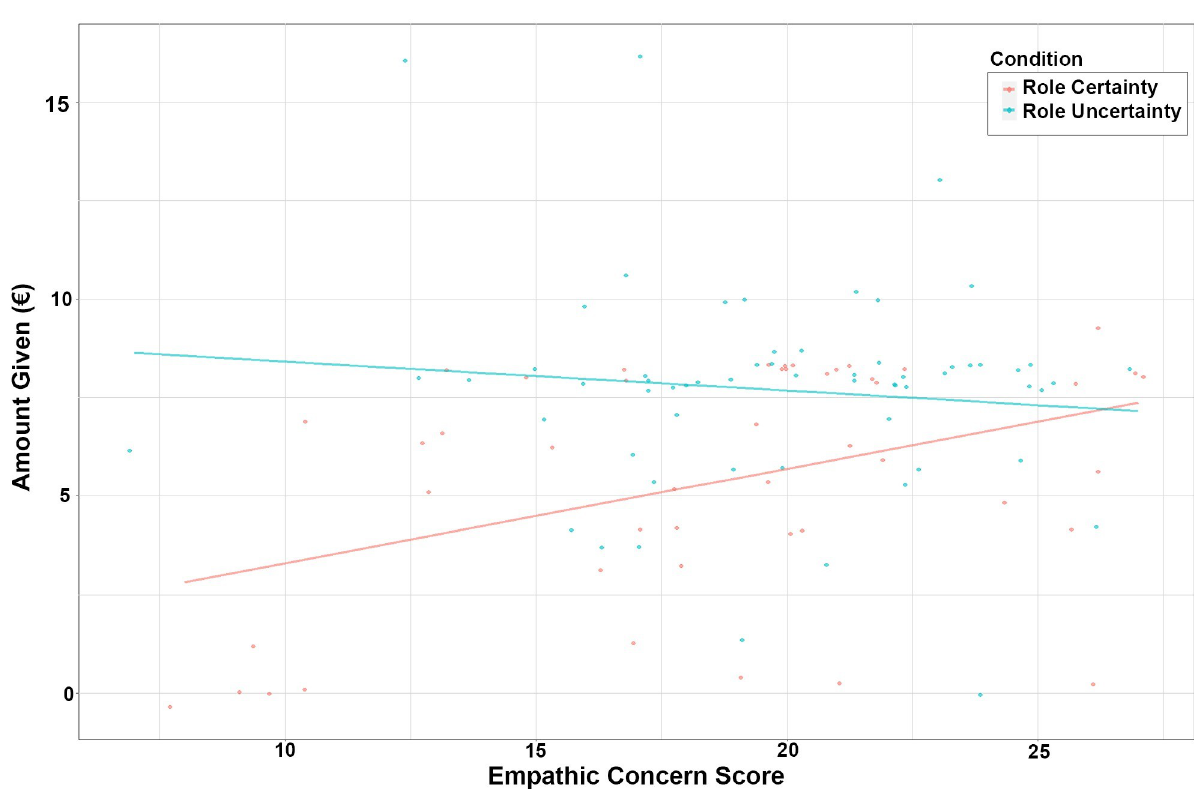
Fig 2. Dictator game giving predicted by the empathic concern score (cyan line: Role uncertainty, red line: Role certainty).